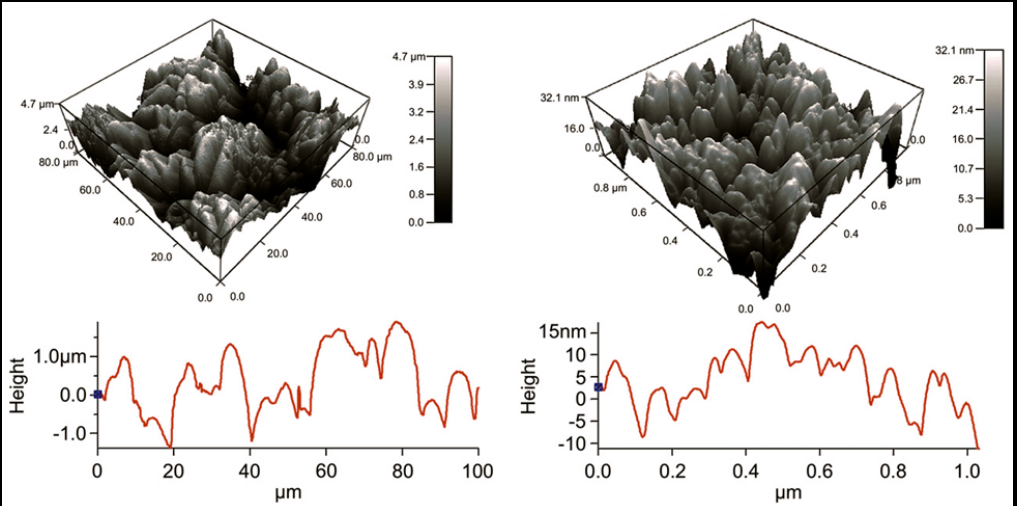
Figure 19. AFM micrographs of PCLF-PPy (PCLT molecular weight of 18,000 g·mol − 1 ) surface microstructure ( left ) with root mean squared (RMS) roughness of 1195 nm and nanostructure with an RMS roughness of 8 nm ( right ). Reprinted with permission from [64]. Copyright 2010 Elsevier